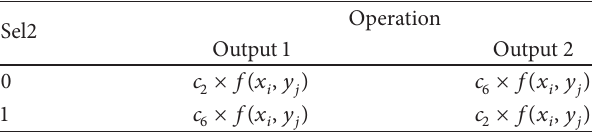
Table 4: Selector S2 attributes according to selection